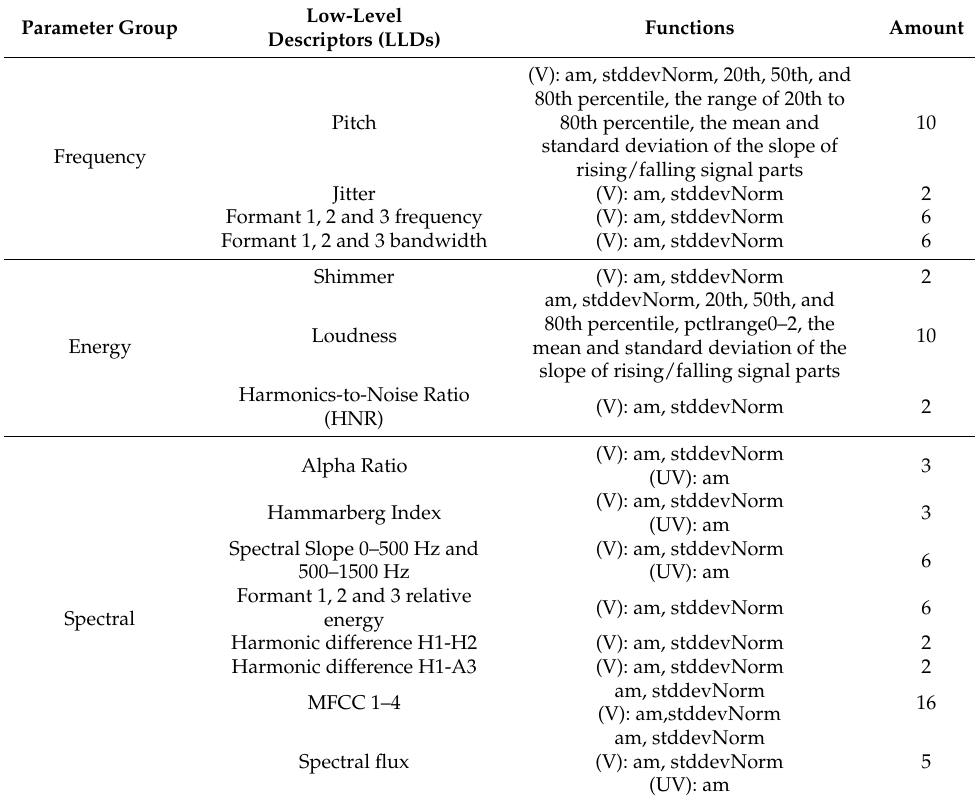
Table 2. Overview of LLDs and functions used in our